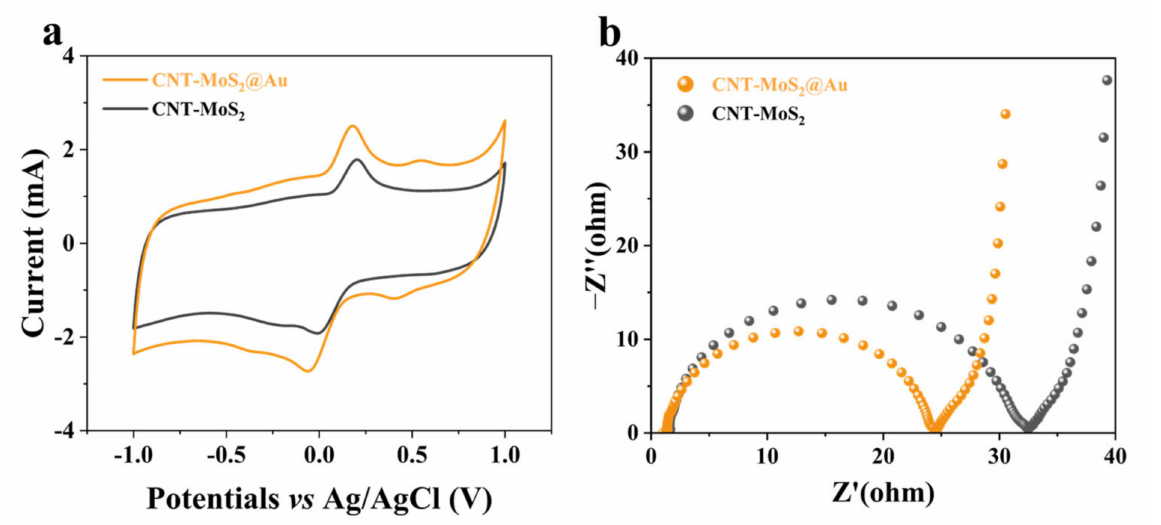
Figure 5. ( a ) CV and ( b ) EIS spectra of the CNT-MoS 2 membrane and CNT-MoS 2 @Au catalytic membrane. The electrolyte contains 50 mM Na 2 SO 4 and 5 mM K 3 [Fe(CN) 6 ]. The CV scan rate was 5 mV/s. The amplitude and scan range in EIS were 5 mV and 10 5 –10 − 2 Hz,